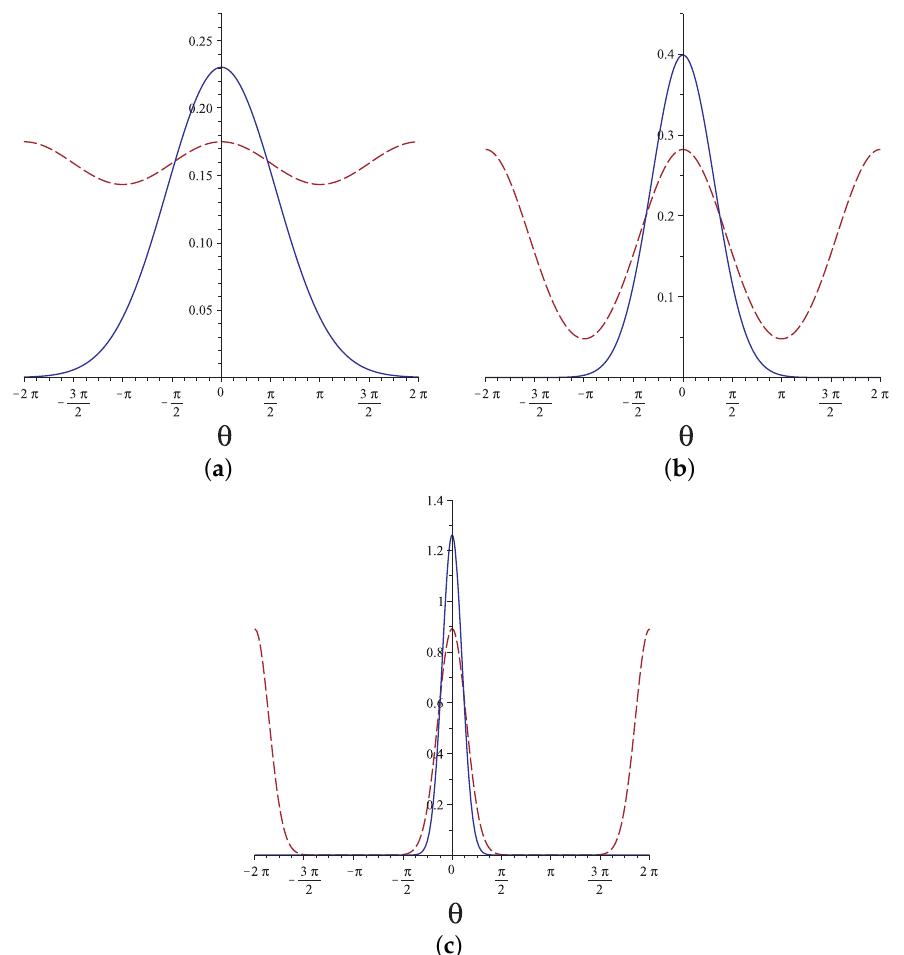
Figure 2. The probability of θ ( L ) (assuming ω = 0) from the Gaussian solution (solid lines) and from the quantum analogy (dashed lines) for ( a ) L / l p = 3, ( b ) L / l p = 1, and ( c ) L / l p =